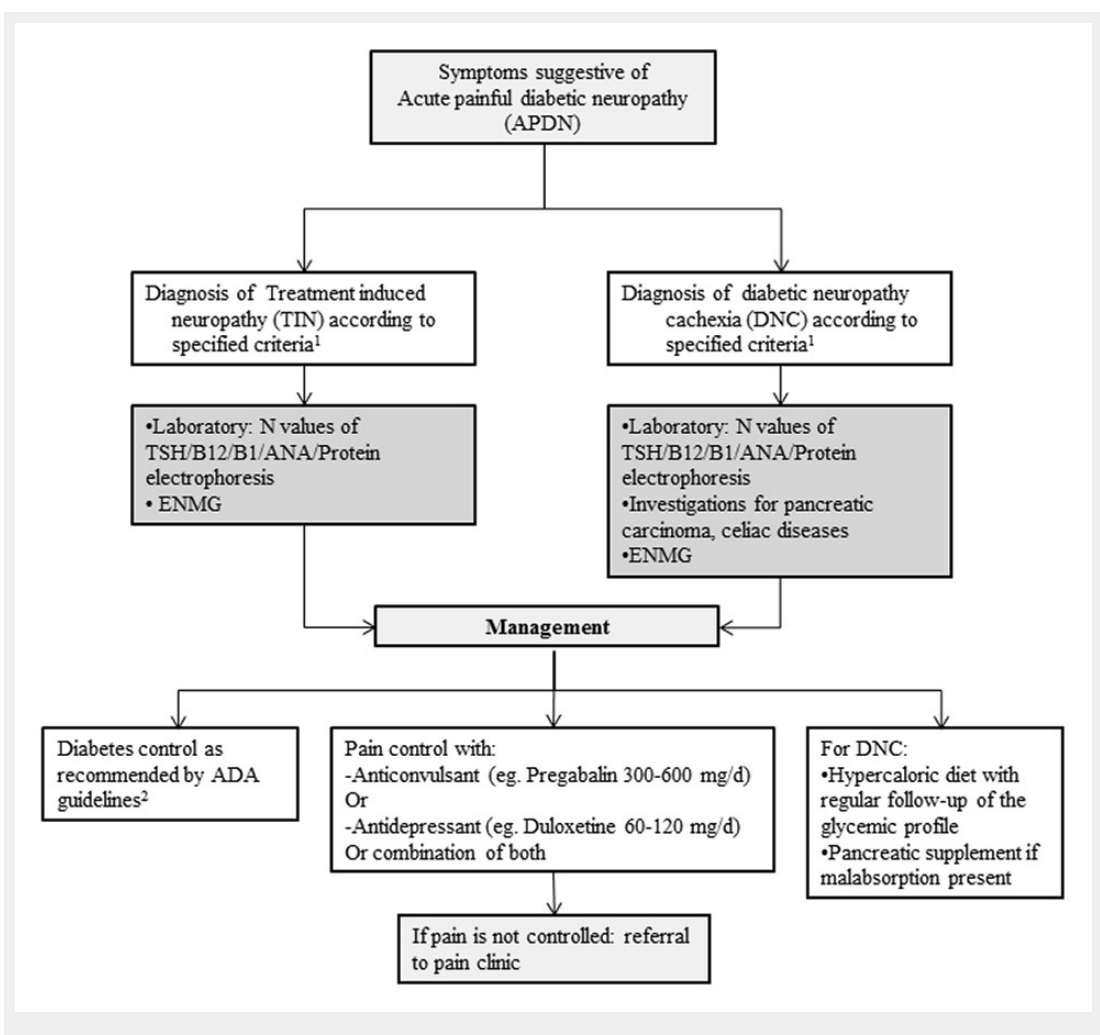
Figure 2 Alogarithm of the approach to acute painful diabetic neuropathy (APDN). ANA = antinuclear antibody; B1 = vitamin B1; B12 = vitamin B12; ENMG = electroneuromyography; N = normal; TSH = thyroid stimulating